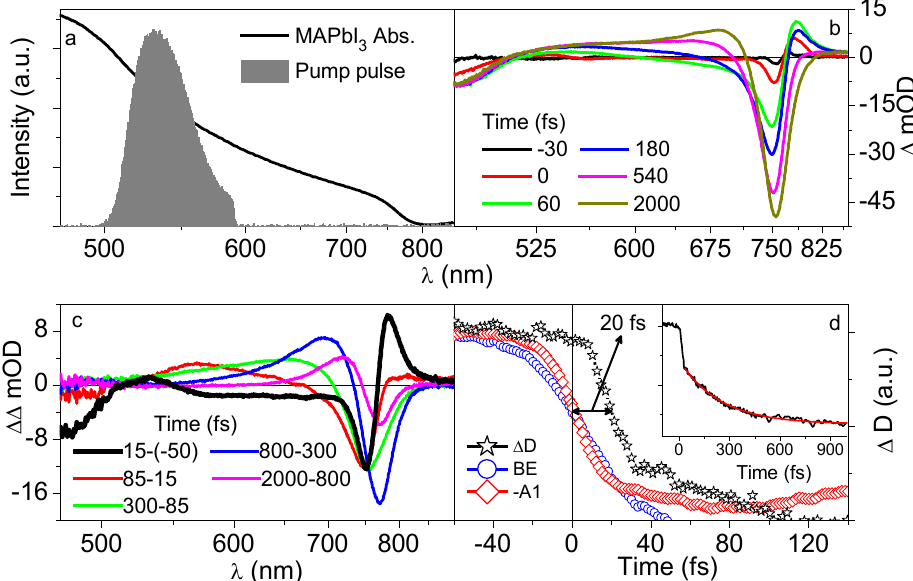
Fig. 1. (a) Absorption spectrum of MAPbI 3 films and pump spectrum. (b) Transient difference transmission and (c) finite different spectra for MAPbI 3 films after 530 nm excitation. Comparison of temporal evolution between band edge (BE) bleach, below BE photoinduced absorption (A1) and band integr al (ΔD) (calculated over 550-900 nm range). Inset shows band integral up to 2